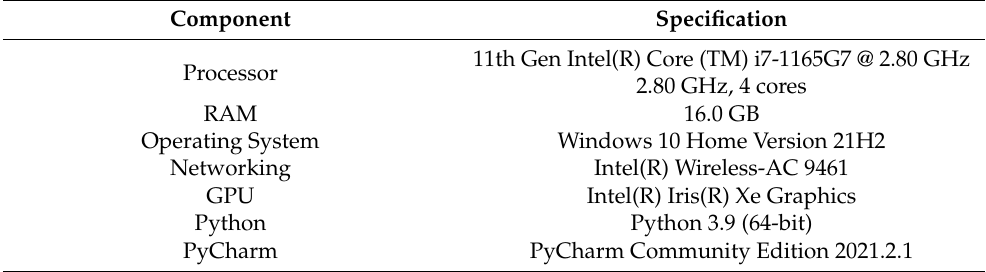
Table 3. Computer specifications.